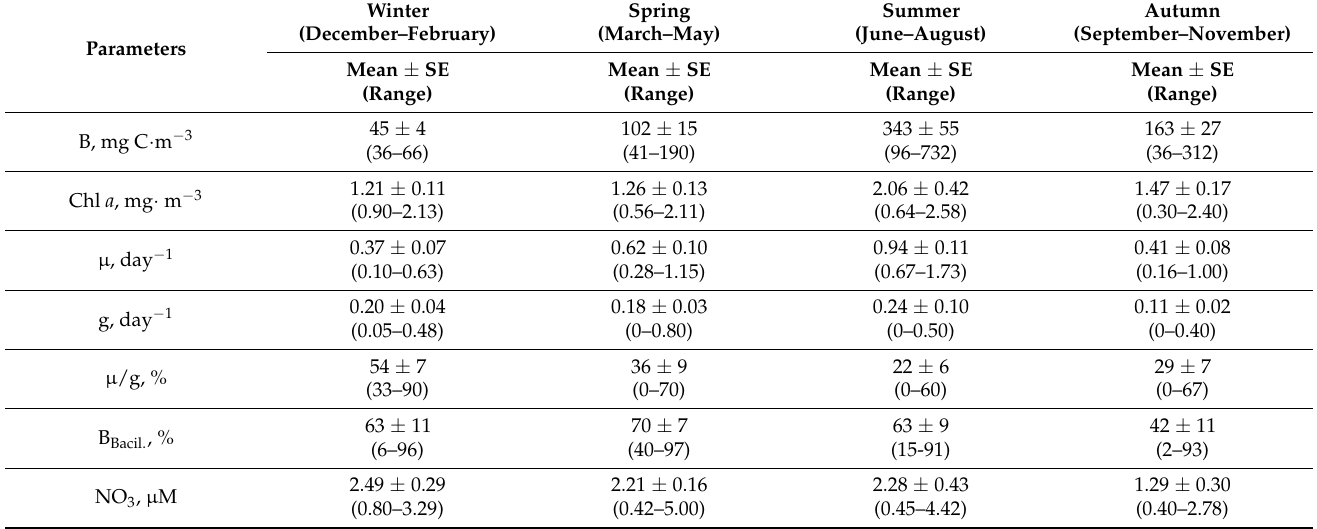
Table 3. Hydrobiological and hydrochemical parameters in the different seasons of